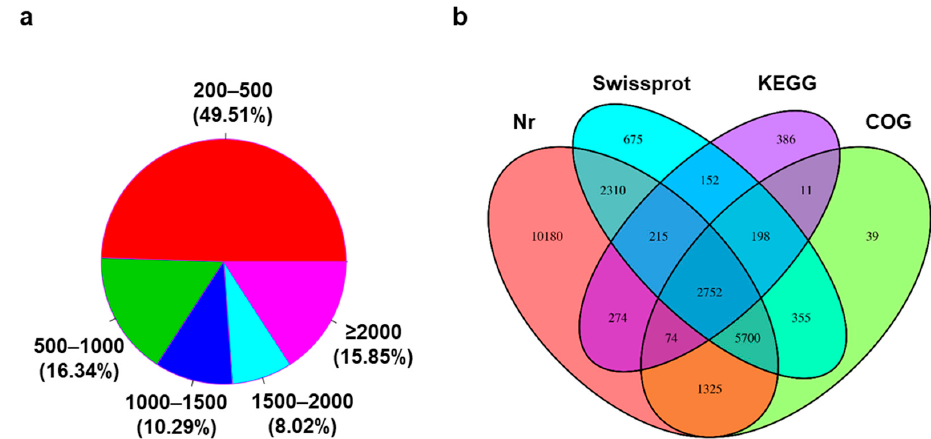
Figure 1. Transcript analysis. ( a ) Pie chart showing the size distribution (length in nucleotides) of the 37,274 F. keratoplasticum transcripts. ( b ) Venn diagram of the number of unique transcripts found in the Nr, Swissprot, KEGG and COG, databases (Nr = 22,830; Swissprot = 12,357; KEGG = 4062; COG = 10,454).